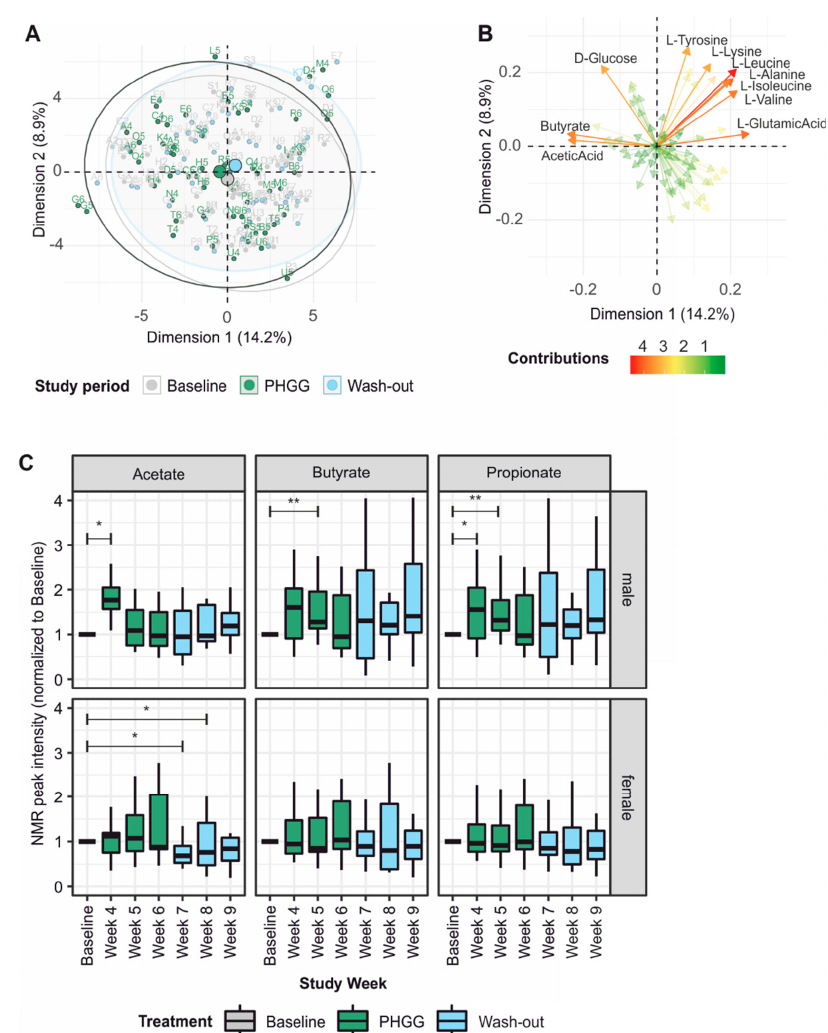
Figure 5. NMR spectroscopy of fecal samples: Peaks were annotated automatically ( A , B ) or manually using reference spectra ( C ). ( A ) Principle component analysis of metabolite profiles by study period indicates a small shift during the PHGG intervention. ( B ) Butyrate and acetate contribute most to the changes seen in A . ( C ) Targeted analysis of SCFA levels in fecal samples reveals sex-dependent changes over time, with most significant effects at the beginning of the intervention period. Pairwise Wilcoxon tests with Bonferroni correction.